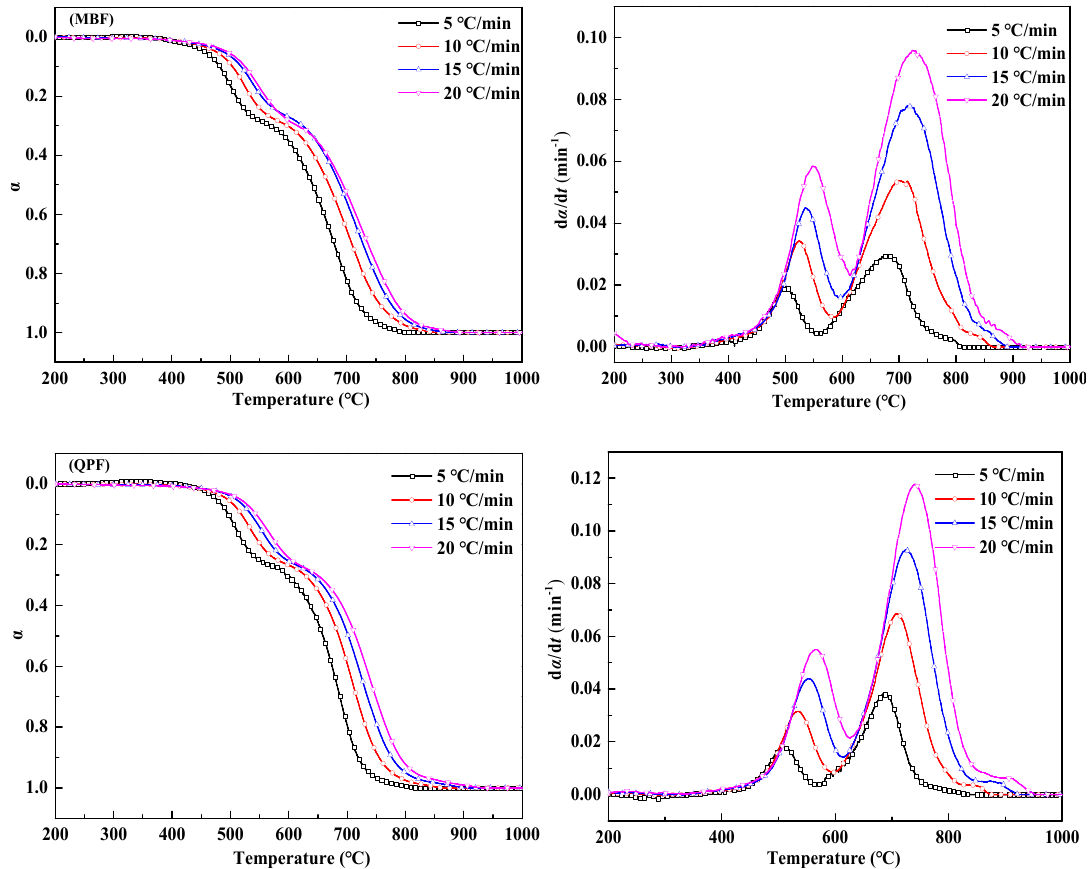
Figure 5. Fractional conversion and reaction rate-conversion curves of MBF and QPF at different heating rates. Table 5. Combustion characteristic parameters of MBF and QPF at different heating rates.